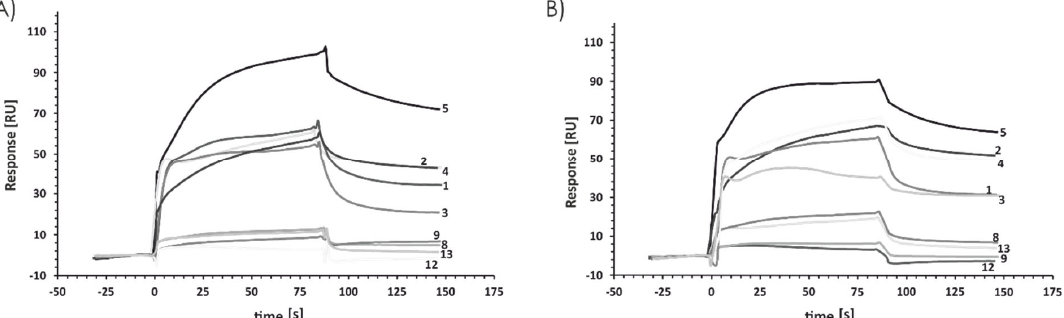
Figure 2S. Cytotoxicity of compounds 1a–9a as assessed by the MTT assay. Two different cell lines were used: A) HB ‐ 2 and B) MDA ‐ MB ‐ 231.